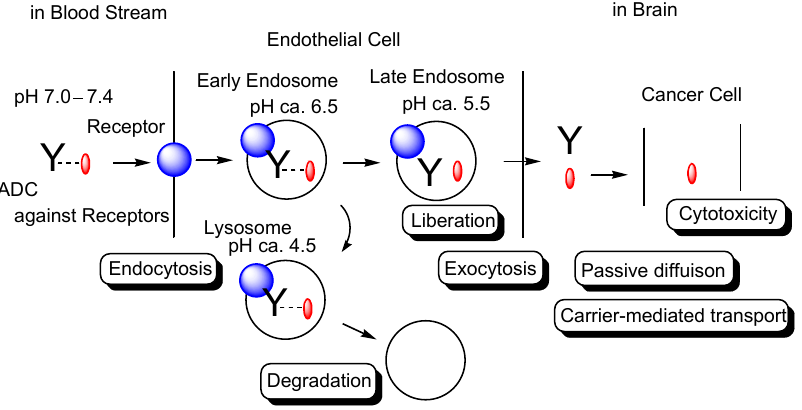
Figure 1. The pathway of intravenously administered antibody-drug conjugates (ADCs) against